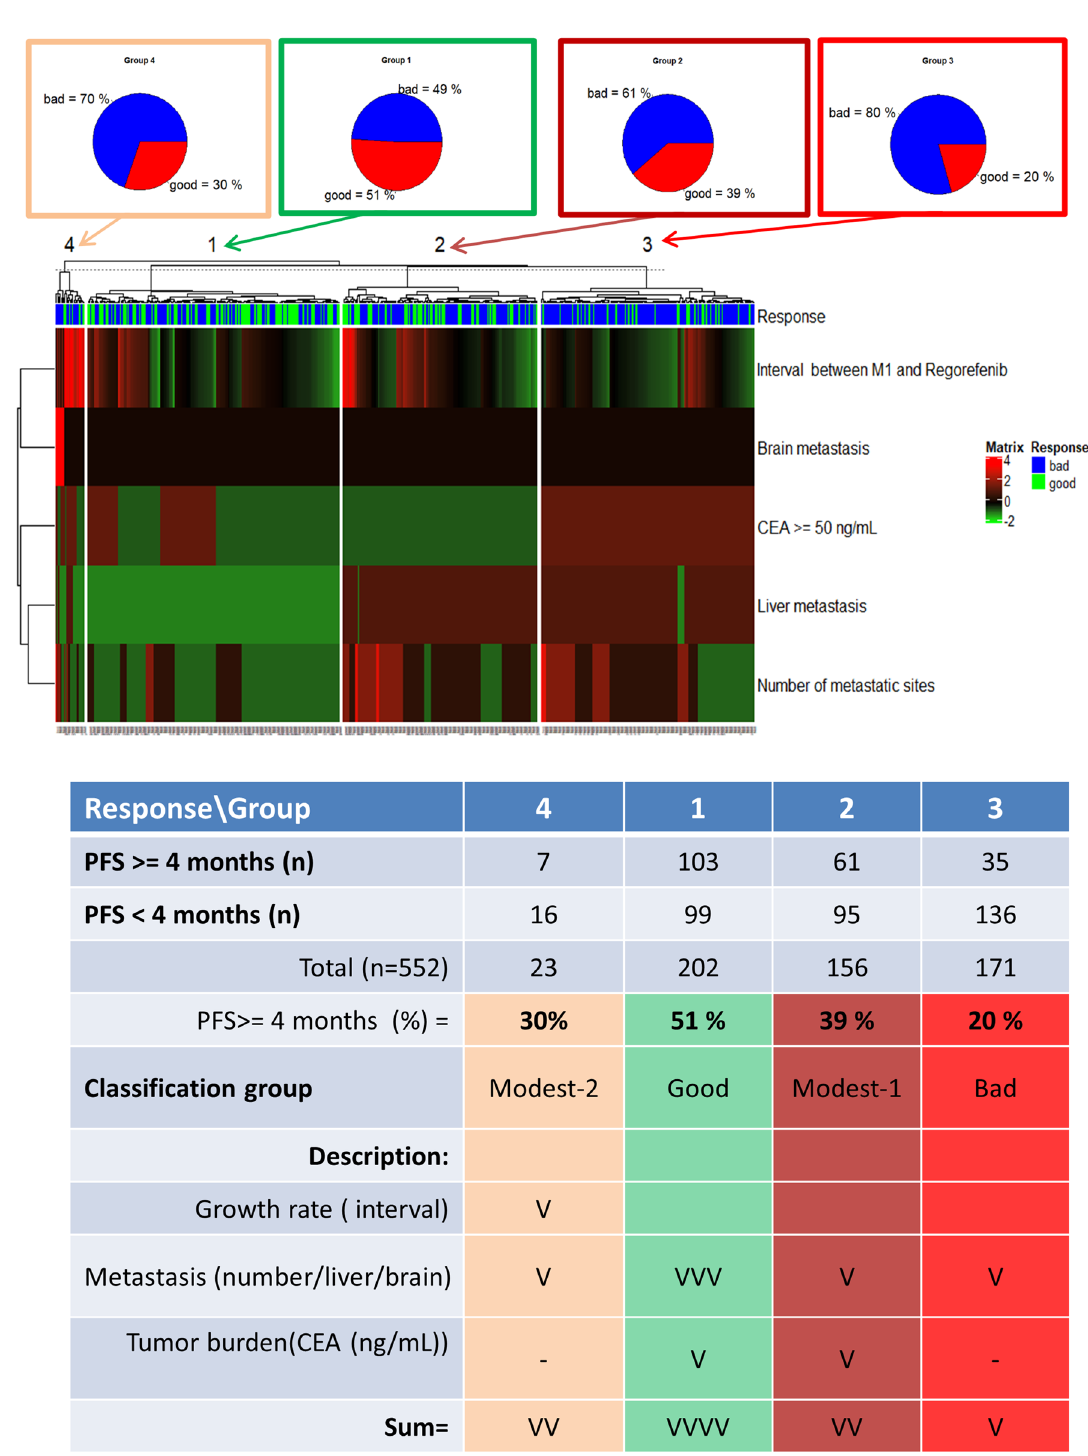
Figure 4. The clustering heatmap (k-means = 4) was used to classify patients into good, bad, modest 1, and modest 2 groups according to significantly independent prognostic factors by PFS > = 4 months or not. (Top) Pie charts represent the distribution of patients with good and bad responses in four groups. (Middle) Clustering heatmap visualizes the different groups’ distribution of independent prognostic factors. (Bottom) Independent prognostic factors were classified into three patterns of cancer behaviors: growth rate, metastasis ability, and tumor burden. It was used to score the grouped patients. Abbreviations: ad, adenocarcinoma; HR, hazard ratio; CI, confidence